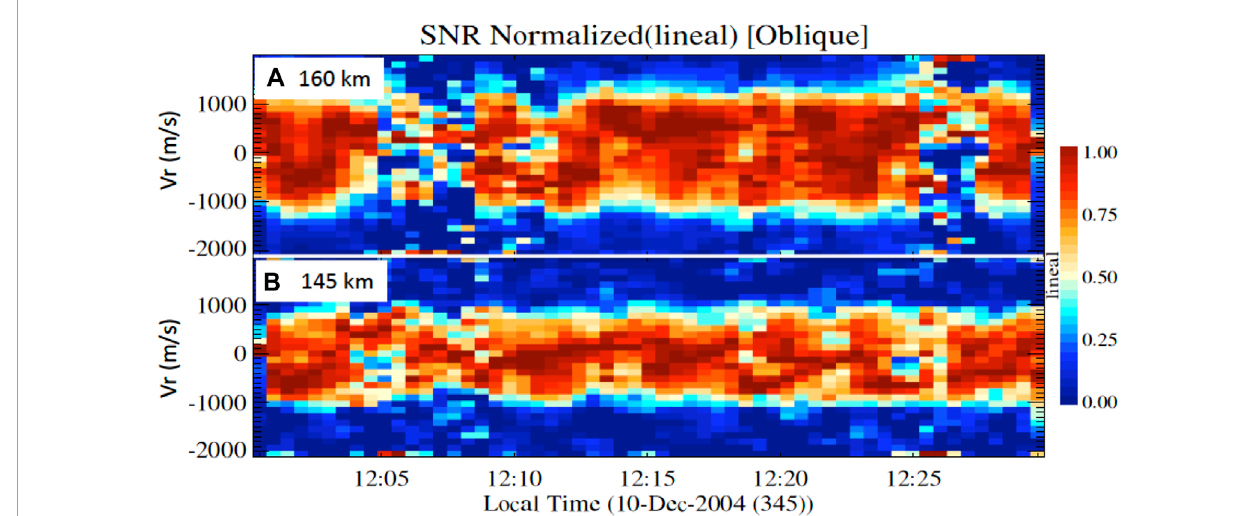
FIGURE 7 Normalized spectrograms of oblique 150-km observations at (A) 160 km and (B) 145 km. These spectra were obtained with high temporal resolution observed over Jicamarca on 10-Dec-2004, i.e., same data used in Chau et al. (2009) and Figure 6B. Note the sub-minute to minute variability of the spectra